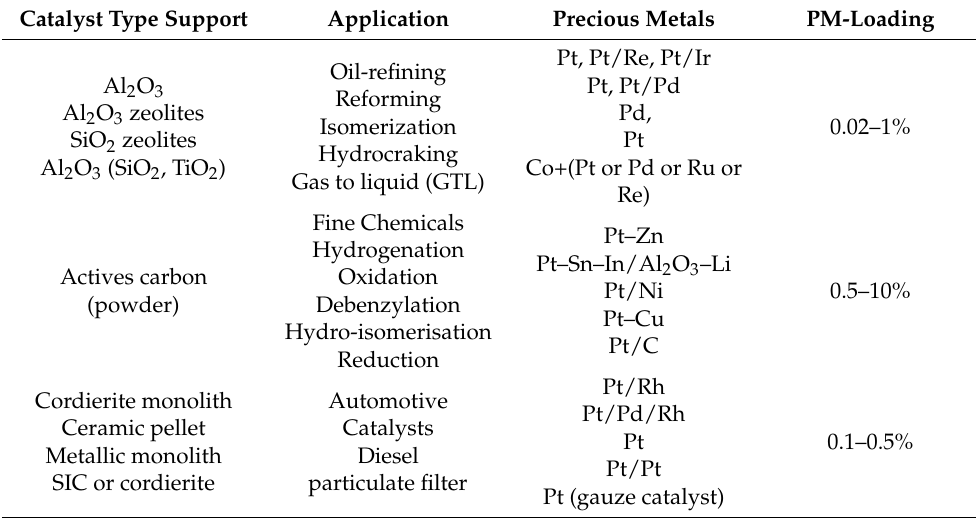
Table 1. Heterogeneous catalysts: support, precious metal (PM) load and applications [17–19]. Catalyst Type